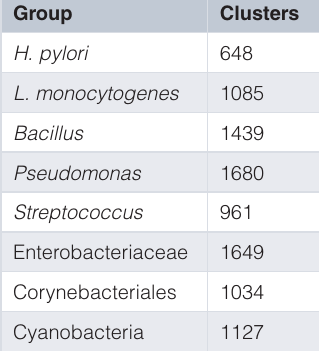
Table 2. Number of identical clusters found with SB and